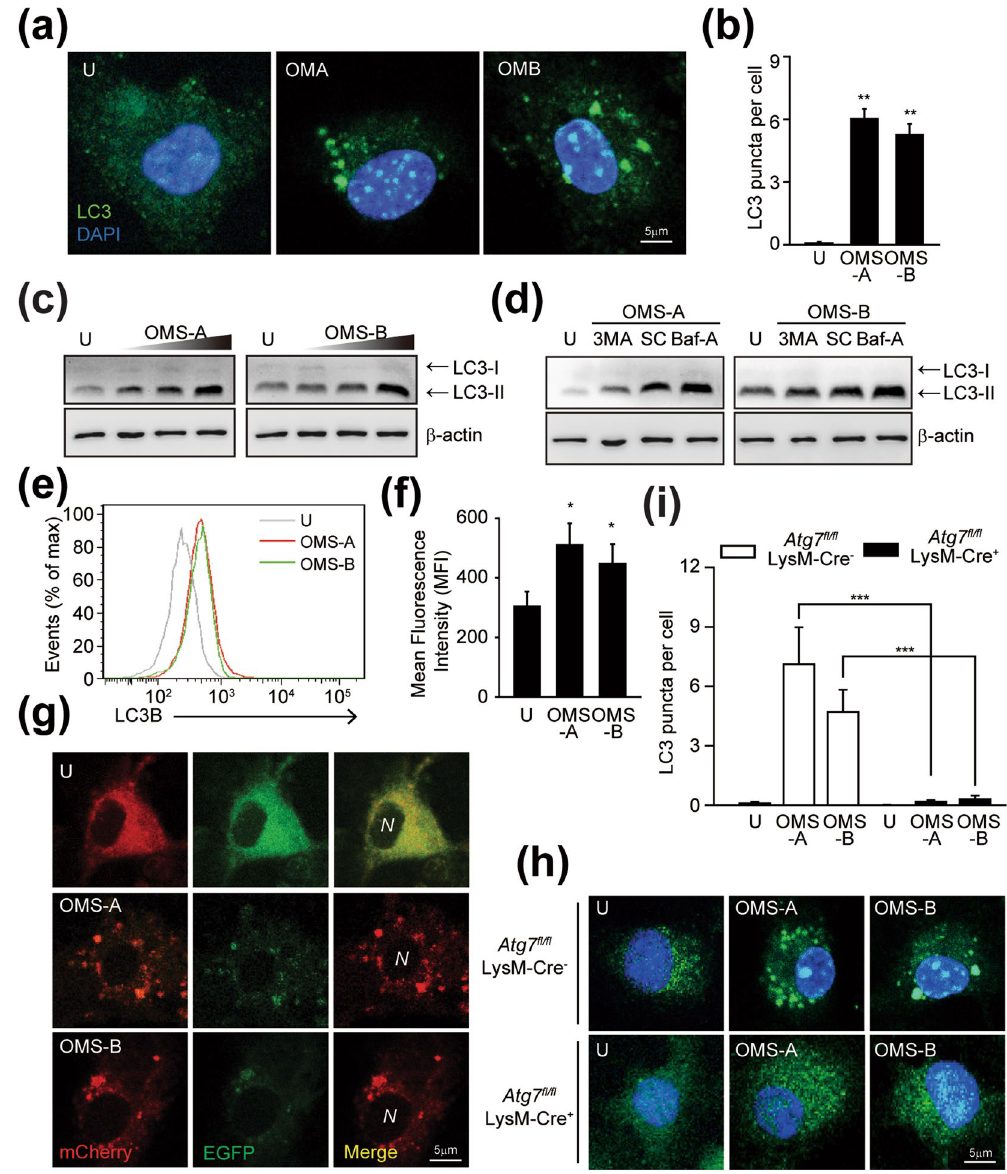
Figure 2. OMS induces autophagy activation in macrophages. ( a and b ) The Alexa 488-conjugated LC3 (green) and DAPI (blue) were detected by confocal microscopy at 24 h of OMS-A (10 μ M; OMA) or OMS-B (10 μ M; OMB) in BMDMs. ( a ) Representative of LC3 images. Scale bar, 5 μ m. ( b ) Quantitative analysis of LC3 puncta per cell. Representative confocal microscopic images from three independent samples are shown, with each experiment including at least 100 cells scored from 6 random fields. ( c ) BMDMs were treated with OMS-A (1, 5, 10 μ M) or OMS-B (1, 5, 10 μ M) for 24 h. ( d ) BMDMs were pretreated with 3-MA (10 μ M, for 2 h), or bafilomycin A1 (100 nM, for 1 h), and then treated with OMS-A or OMS-B for 24 h. ( c and d ) Cell lysates were subjected to immunoblot analysis of LC3 and Actin. The entire blots are shown in Supplementary Fig. 6. ( e and f ) Flow cytometric analysis of LC3B expression at 24 h of OMS-A or OMS-B treatment. ( f ) Quantitative analysis of LC3B expression. ( g ) BMDMs were transduced with retrovirus expressing a tandem-tagged mCherry-EGFP- LC3B and then treated with OMS-A or OMS-B for 24 h. Cells were tandem LC3B plasmid was detected by confocal microscopy. Scale bar, 5 μ m. ( h , i ) Atg7 fl/fl LysM-Cre − and Atg7 fl/fl LysM-Cre + BMDMs were treated with OMS-A (10 μ M) and OMS-B (10 μ M) for 24 h. The Alexa 488-conjugated LC3 (green) and DAPI (blue) were detected by confocal analysis. ( h ) Representative of LC3 images. Scale bar, 5 μ m. ( i ) Quantitative analysis of LC3 puncta per cell. Representative confocal microscopic images from three independent samples are shown, with each experiment including at least 100 cells scored from 6 random fields. Data shown are from one representative of at least three independent experiments (means ± SD of triplicates [ b , f , i ] samples). * p < 0.05, ** p < 0.01, *** p < 0.001, compared with untreated control or Atg7 fl/fl LysM-Cre − ( b , e ). U, untreated; Baf-A, bafilomycin A1; SC, solvent control; N;